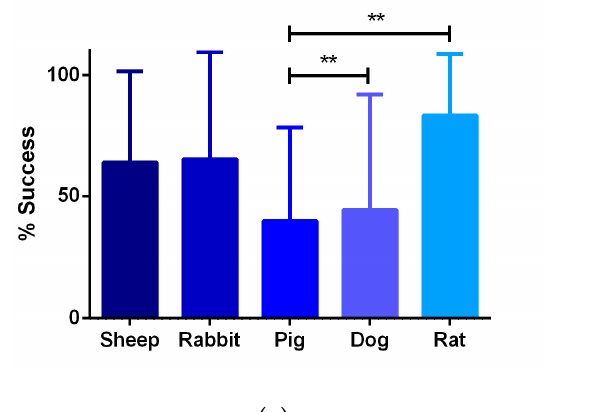
8 of 25 Figure 3. Survival curve of tissue ‐ engineered vascular grafts in preclinical studies. The survival curve presented starts with all the specimens participating in preclinical studies for each of the spe ‐ cies evaluated. When a given number of individuals does not overcome a given phase of the inte ‐ gration process, it is subtracted from the total number of specimens participating, reducing the per ‐ centage of animals surviving the study. Furthermore, the review showed that the proposed critical phases and types of fail ‐ ure are observed in every animal model. However, studies involving smaller animal mod ‐ els are characterized by shorter evaluation times, and therefore they arrive at later phases